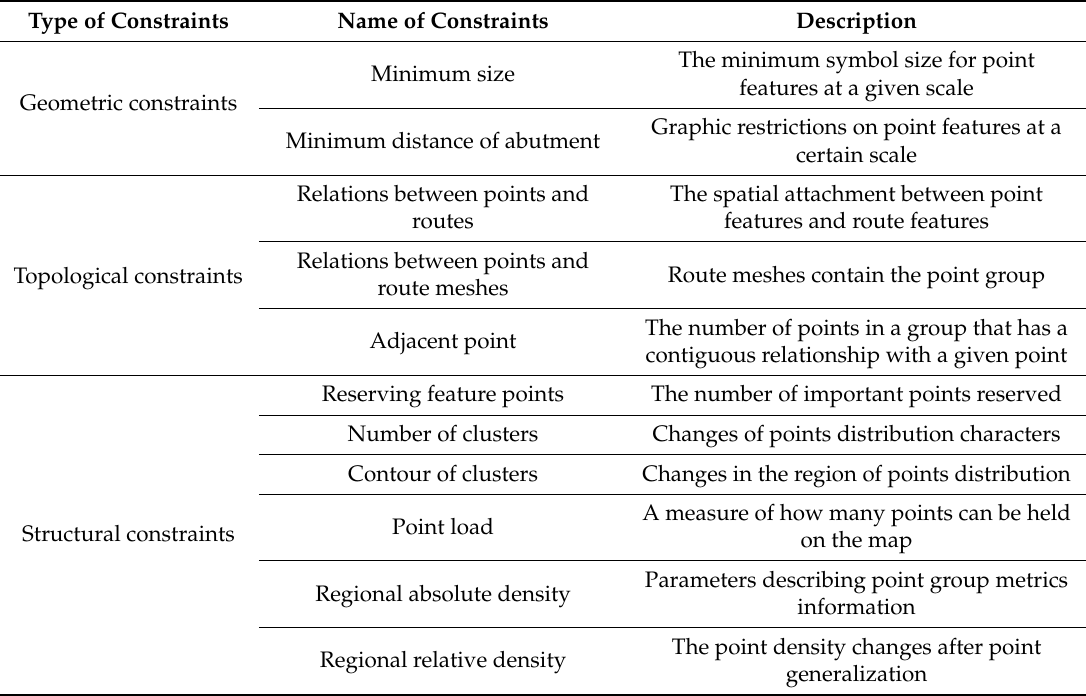
Table 1. Traditional point generalization